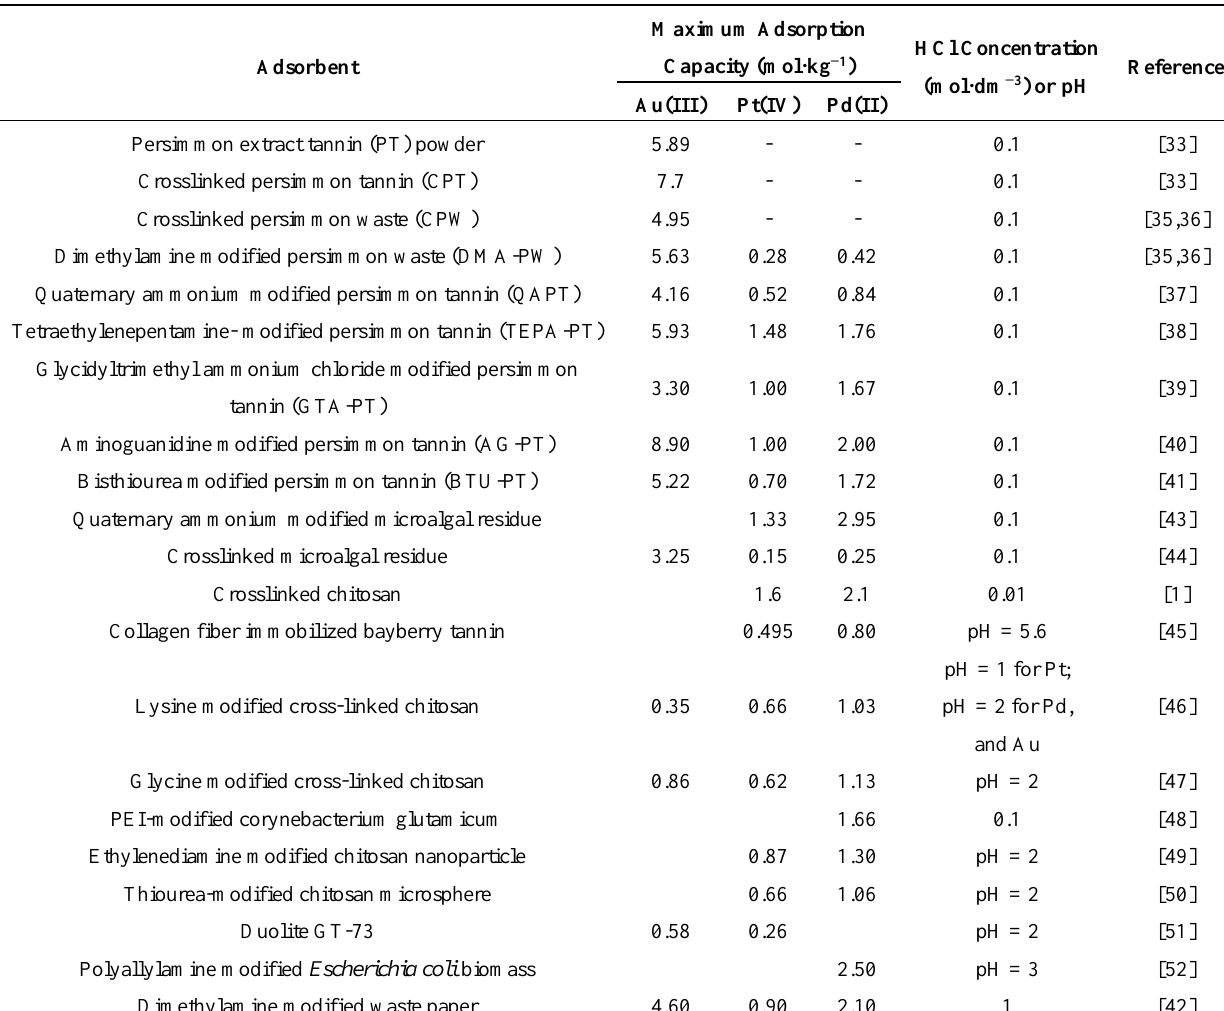
Table 3. The maximum adsorption capacities of gold(III), platinum(IV) and palladium(II) on various